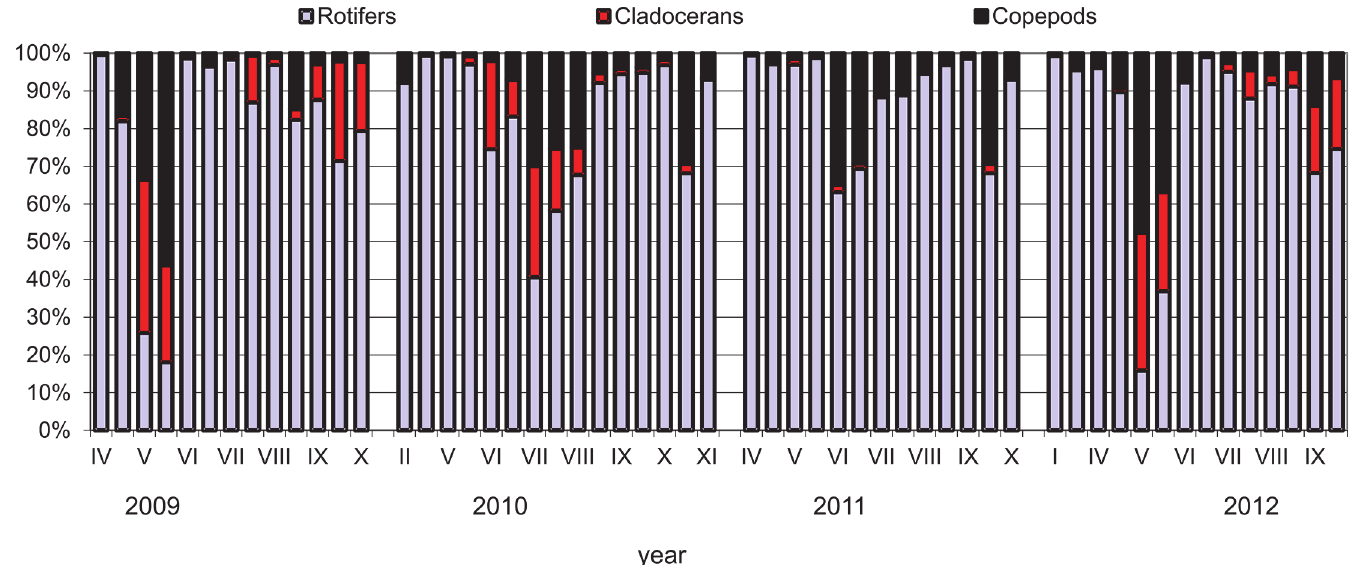
Fig 8. Share of the abundance of zooplankton groups in Malta ń ski Reservoir (an example from the depth of 2 m).